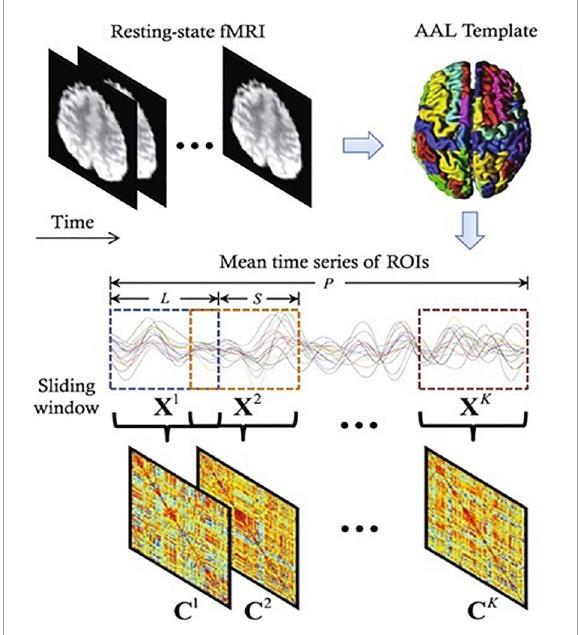
FIGURE2 A diagram depicting the construction of functional connectivity (FC) networks using sliding window-based Pearson’s correlation on rs-fMRI data (65). Where P, L, S, C, and X represents time points, window length, step size, correlation strength, and number of windows, respectively.